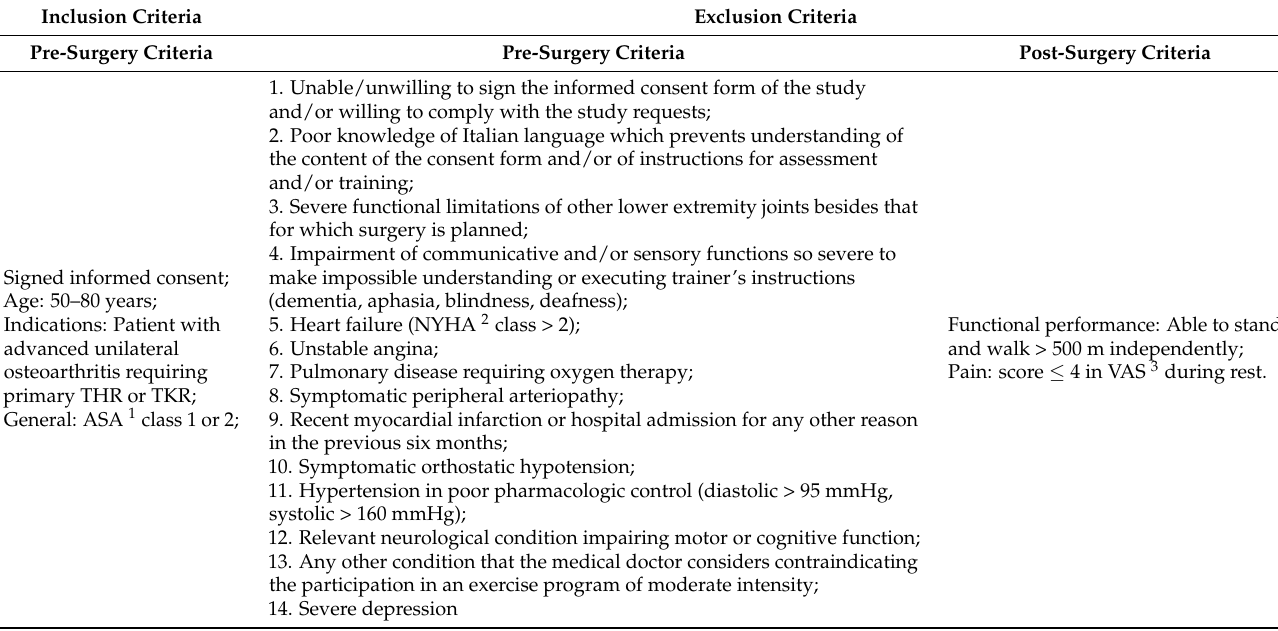
Figure 1. Study design. Table 1. Inclusion and exclusion